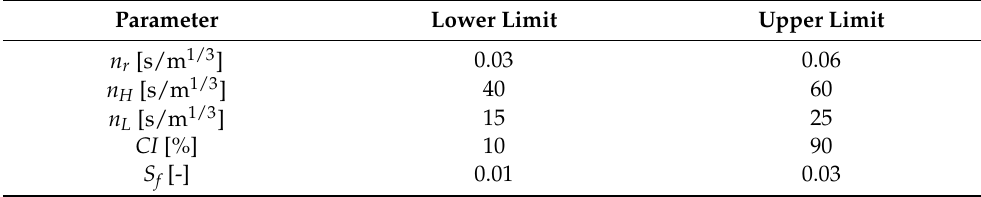
Table 1. Parametric